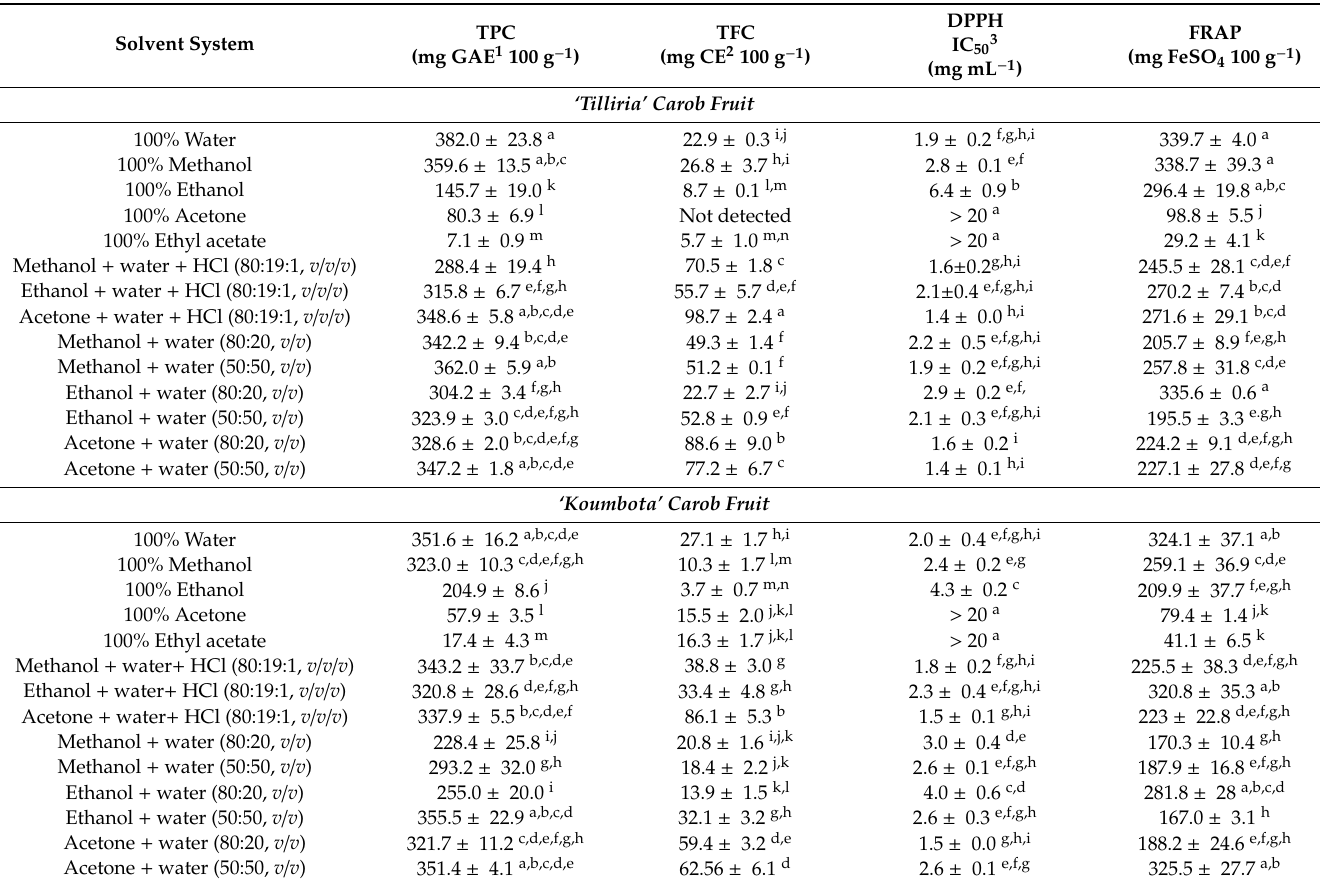
Table 1. E ff ect of extraction solvents on total phenolic content (TPC), total flavonoid content (TFC), and antioxidant activity of the carob extracts. Results are the means ± standard error. Labelled with the same letter did not di ff er significantly ( p ≤ 0.05) according to Duncan’s